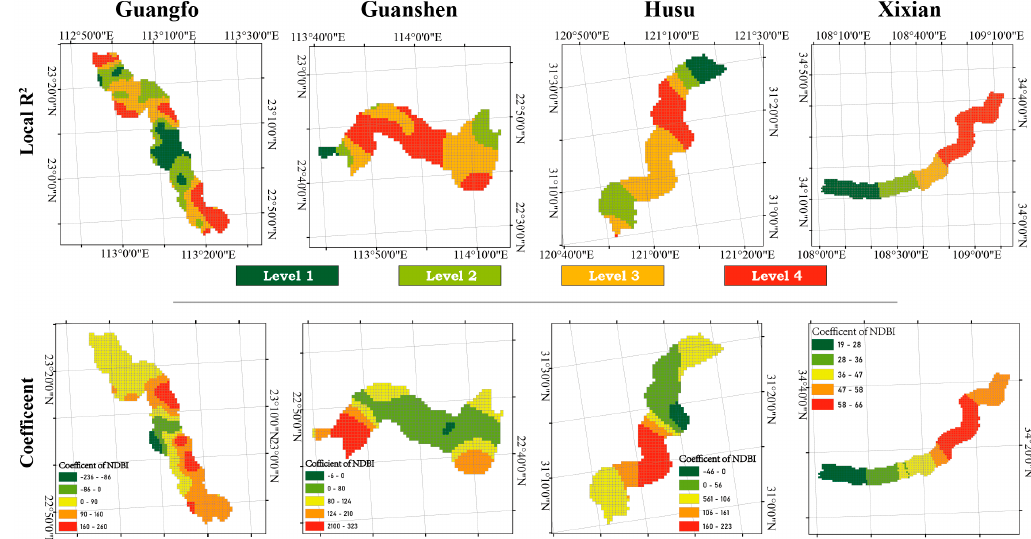
Figure 5. The local R 2 and coefficient distribution map of integrated cities in 2017.